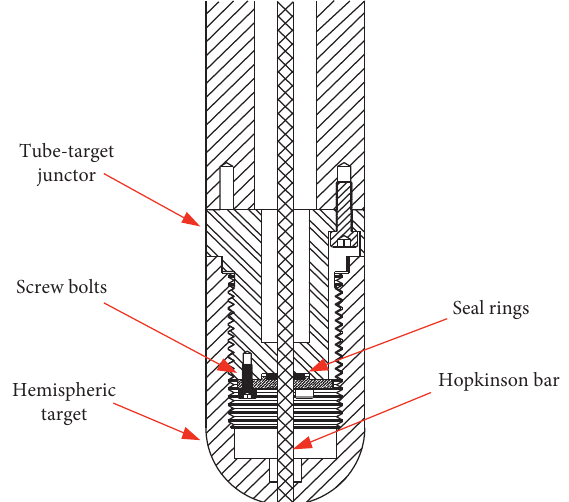
Figure 1: Detailed schematic of the